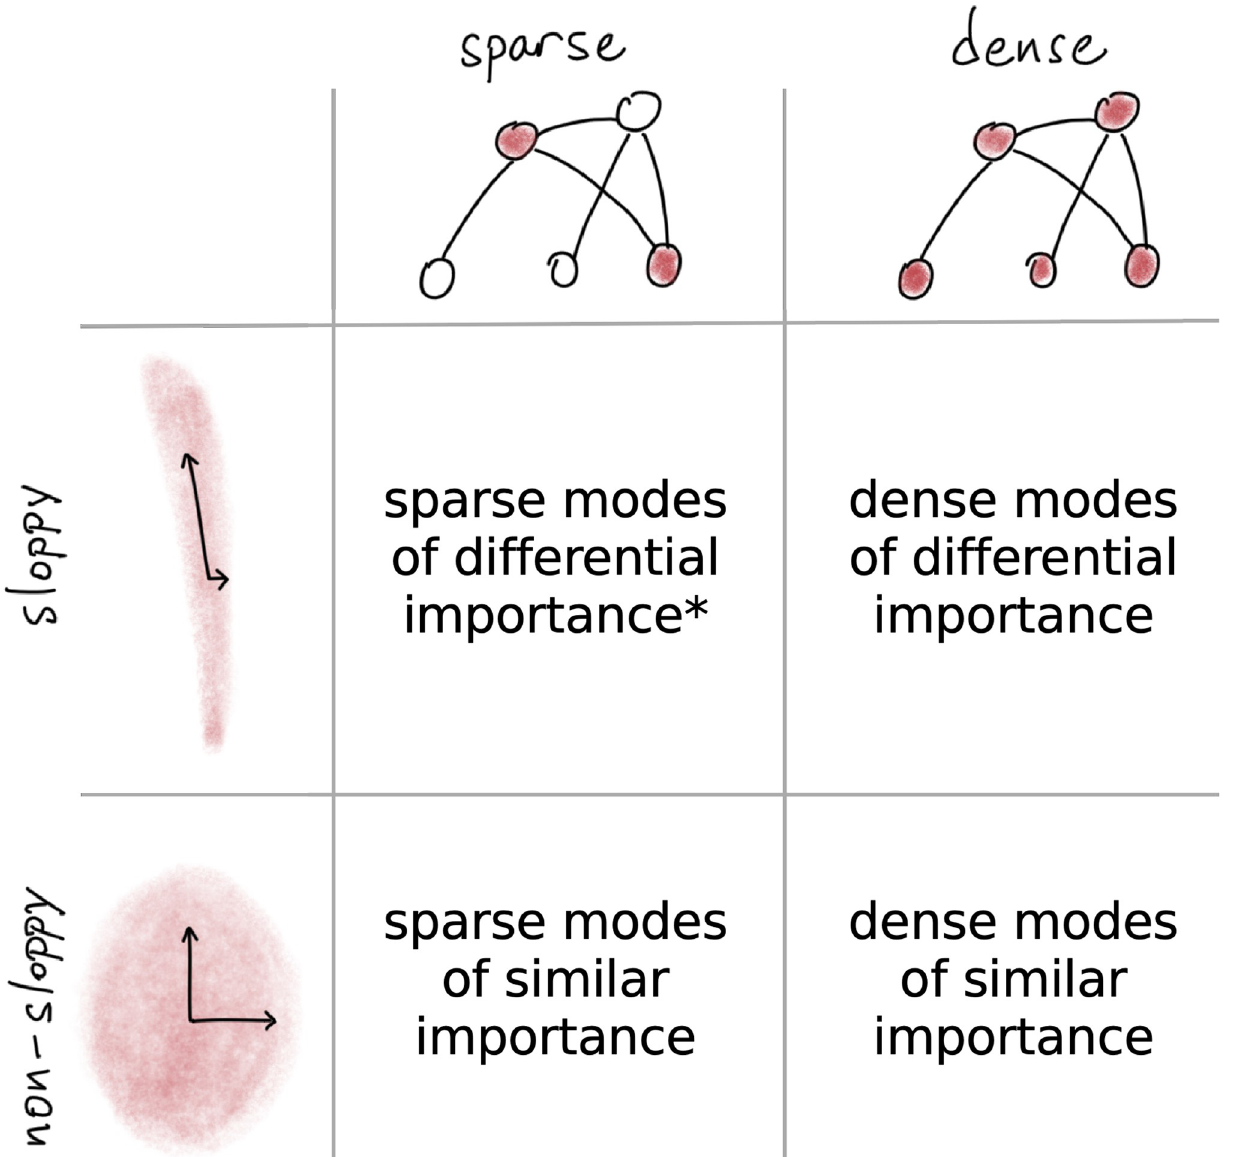
Fig 1. Four possibilities for sparse sensitivity. When collective activity shows sloppy structure, the local information geometry is elongated along sloppy, insensitive directions. With dense collective encoding, multiple components each matter equally. Starred combination with sloppy, sparse combinations of neurons aligns with centralized